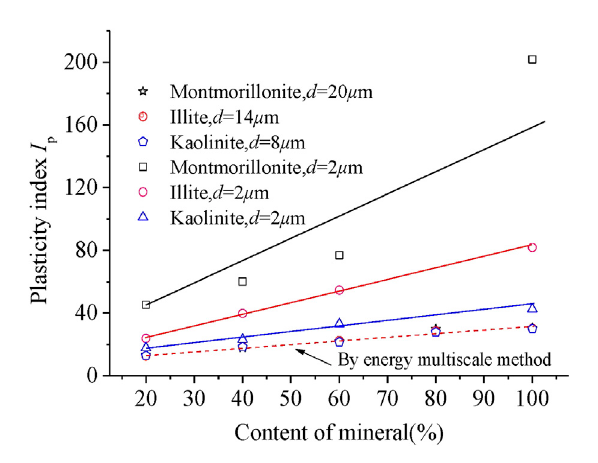
FIGURE 8 Plasticity index of soil samples with different mineral contents using the energy multi-scale